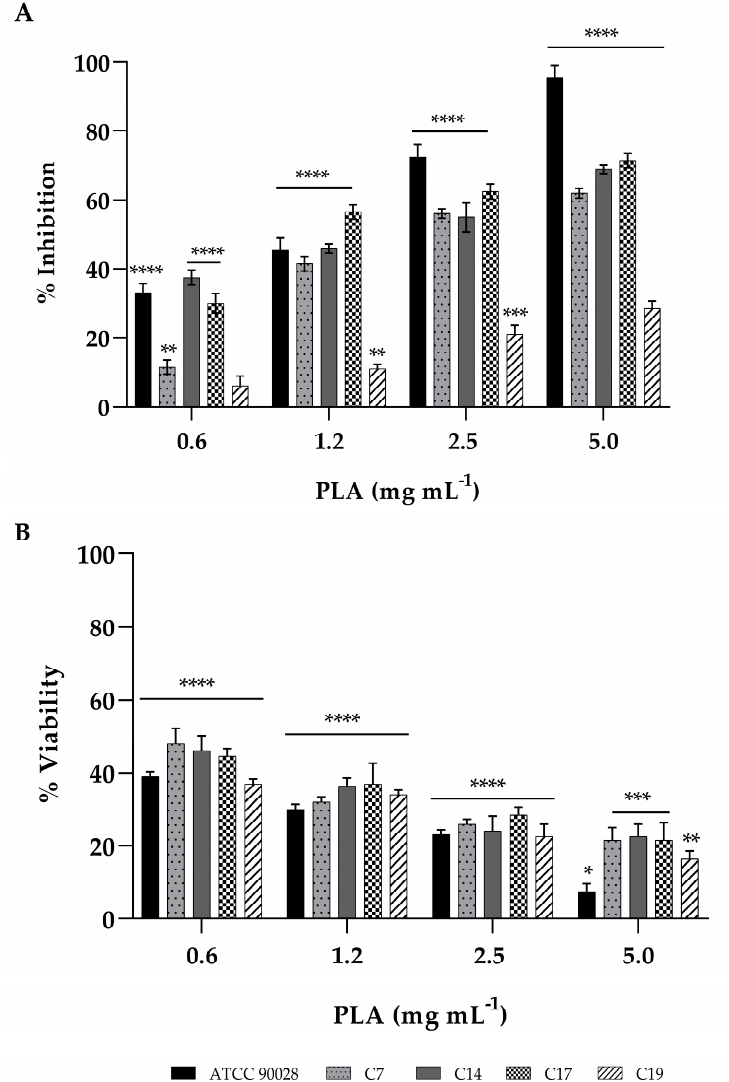
Figure 3. Inhibition of biofilm formation by PLA at concentrations of 0.6, 1.2, 2.5, and 5 mg mL − 1 against C. albicans ATCC90028 and clinical isolates C7, C14, C17, and C19. Two different methodol- ogies were used to quantify biofilm: crystal violet assay (panel A ), which measures biofilm total biomass, and XTT assay (panel B ), which measures metabolic activity. Data represent the mean (± standard deviation, SD) of three independent experiments, and each one was carried out with trip- licate determinations. For all experimental points, * p < 0.05, ** p < 0.01, *** p < 0.001, or **** p < 0.0001 were obtained for treated samples versus untreated samples (Tukey’s test).